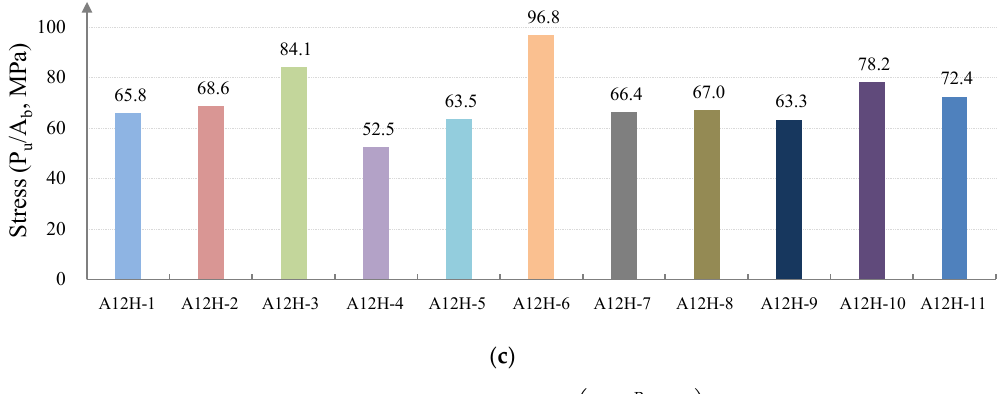
Figure 5. Test results: ( a ) maximum load; ( b ) load-carrying efficiency ( P u / A b ).